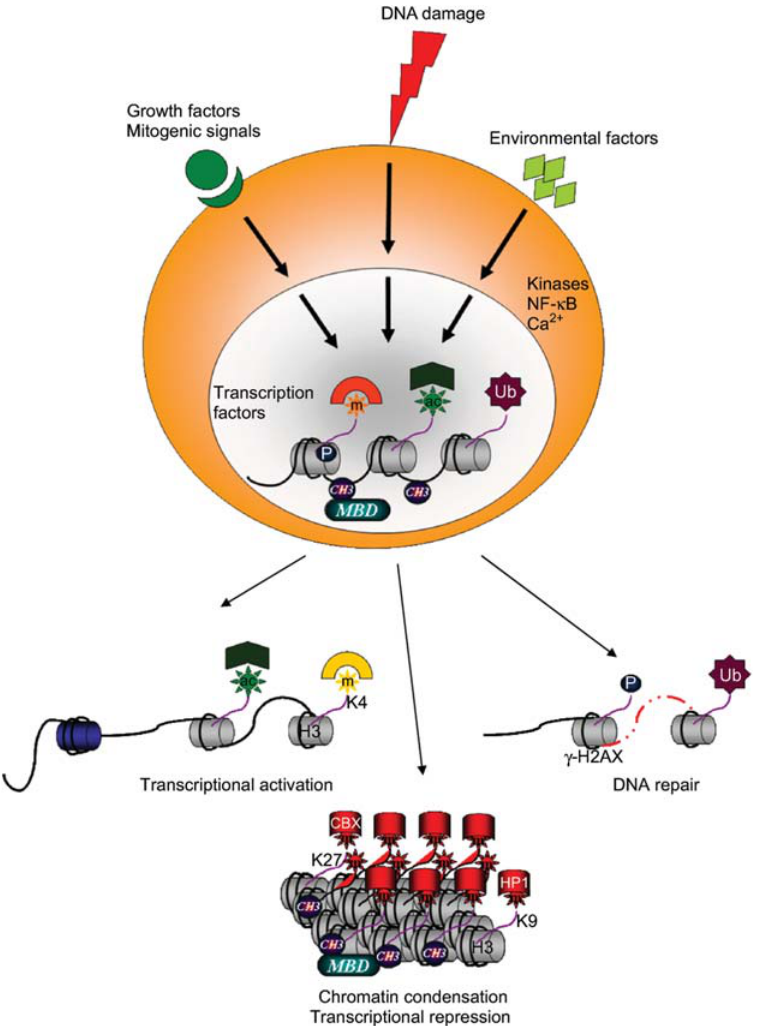
Figure 1 Integrative overview of mechanisms involved in the regulation of chromatin conformation and some of the pleiotropic functions regulated by the chromatin in response to different